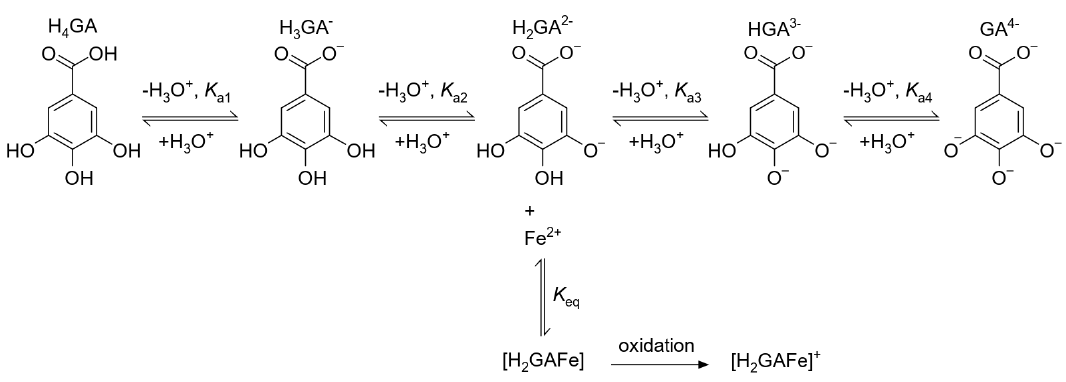
Figure 2. Model B reaction scheme in which H 2 GA 2 − reacts with iron(II) ions. This forms a coordination compound [H 2 GAFe], which later irreversibly oxidizes into [H 2 GAFe] +